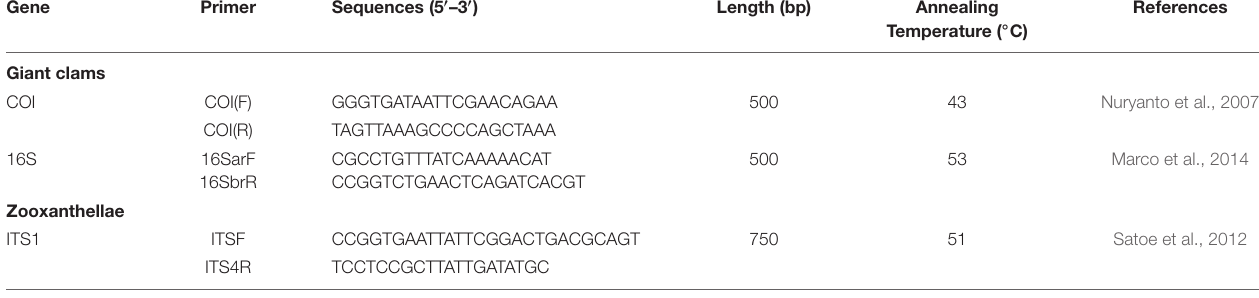
TABLE 1 | Information of primers used in this study.